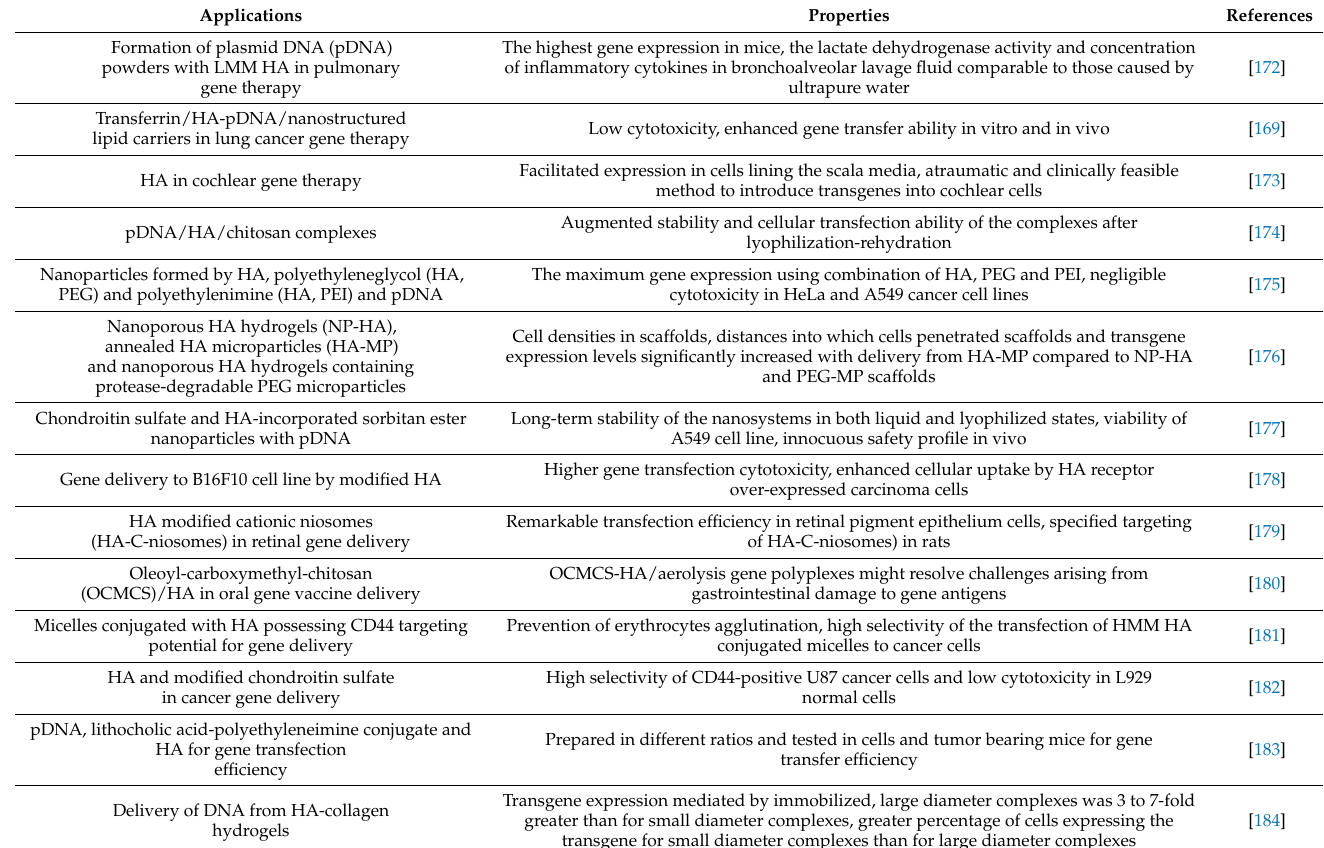
Table 3. Application of HA in gene